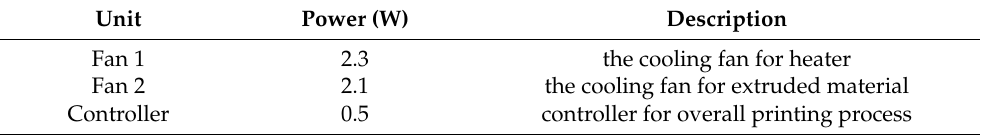
Table 1. Power of